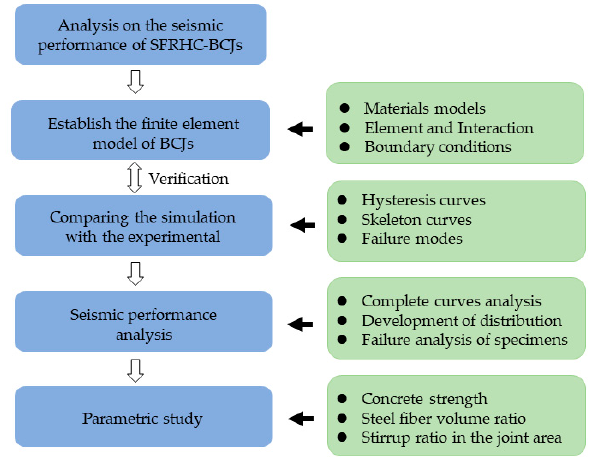
Figure 1. The flowchart of SFRHC–BCJs.